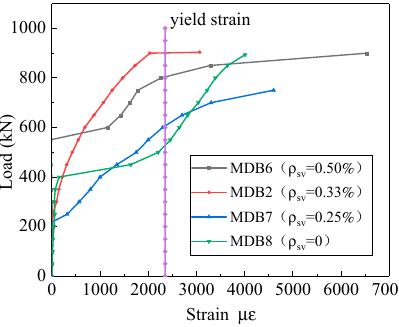
Figure 20. Relation curve between ρ sv and horizontal distributing reinforcement strain.